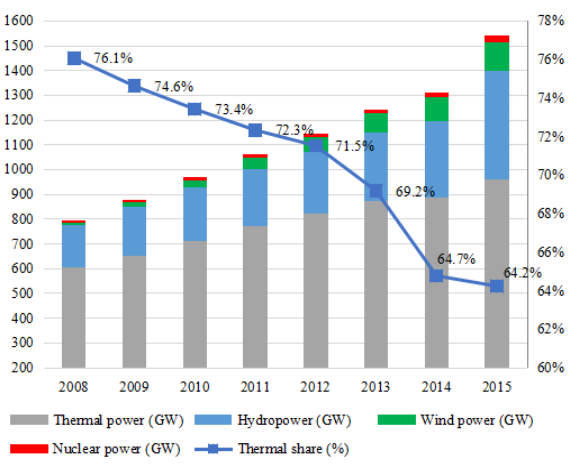
Figure 8. Power generation capacities and the share of thermal power in China, 2008–2015.